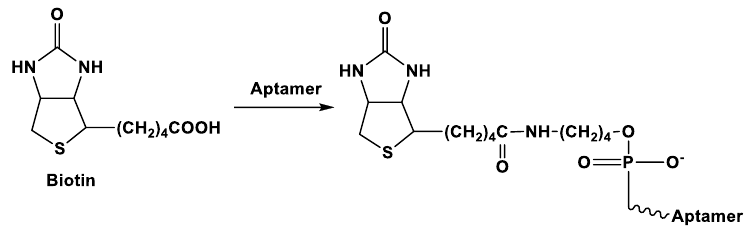
Figure 6. Biotinylated aptamer synthesis.